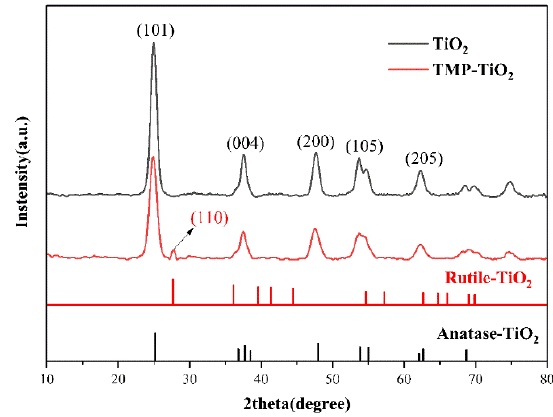
Figure 4. XRD spectra of TiO 2 and TMP ‐ TiO 2 .